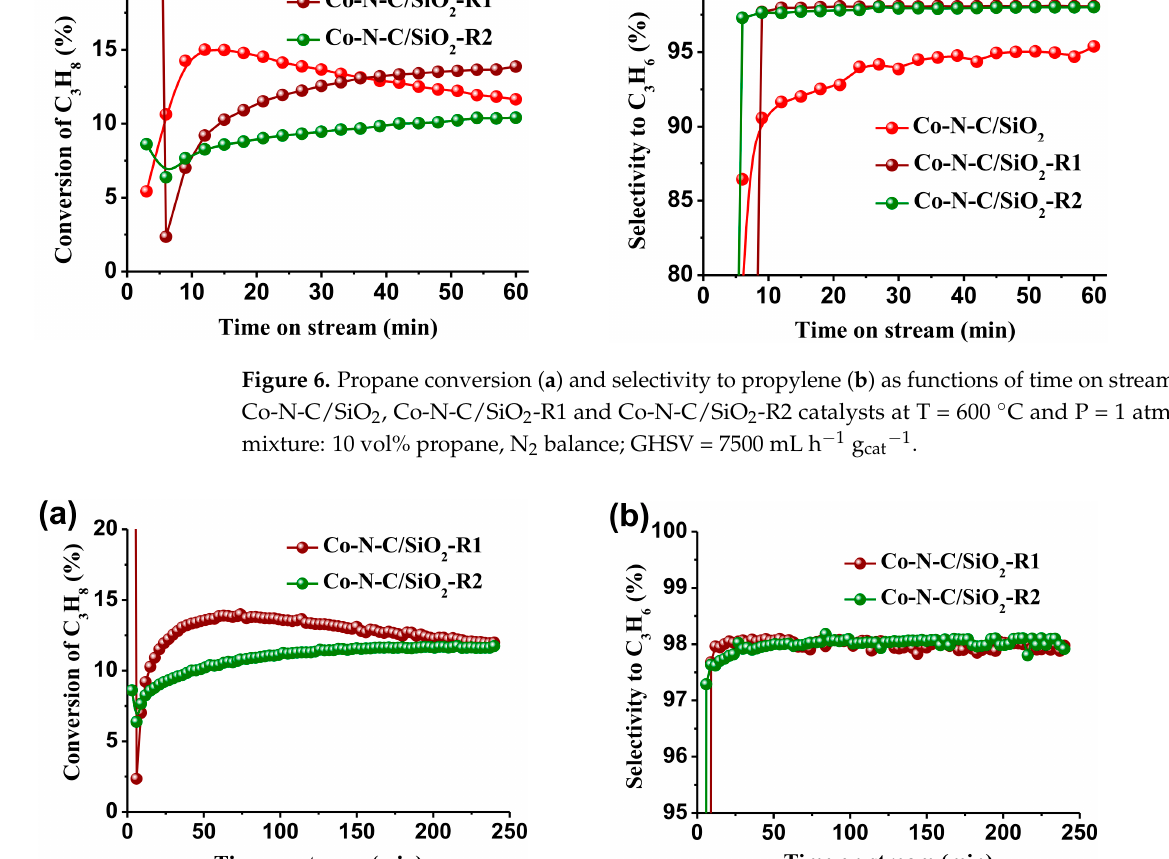
Figure 7. Longer-term conversion of propane ( a ) and selectivity to propylene ( b ) as functions of time on stream over Co-N-C/SiO 2 -R1 and Co-N-C/SiO 2 -R2 catalysts at T = 600 °C and P = 1 atm. Gas